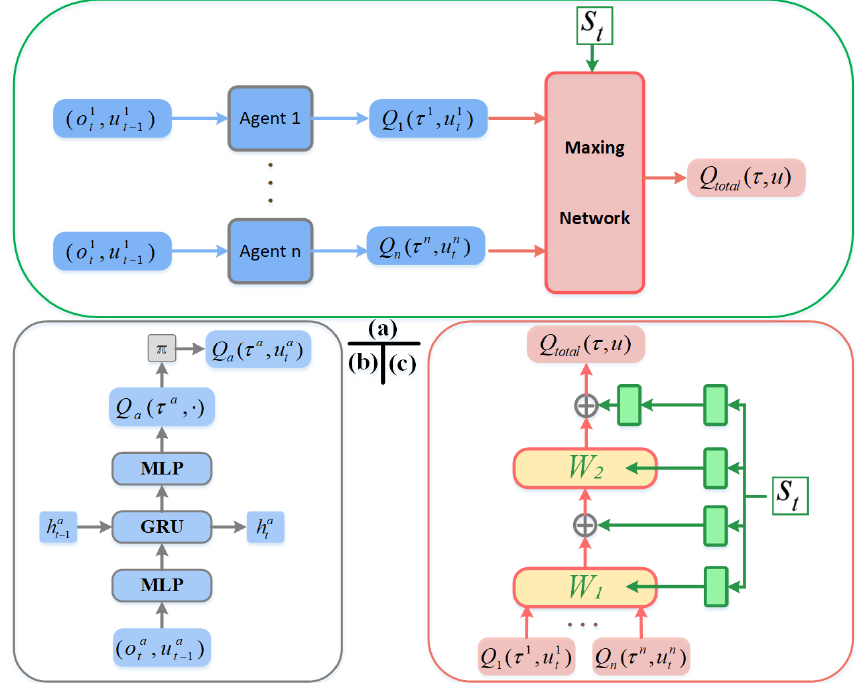
Figure 8. ( a ) The overall QMIX architecture; ( b ) Agent network structure; ( c ) Mixing network struc- ture.